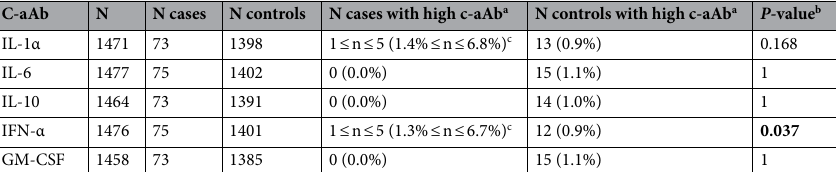
Table 4. Number and proportion of RLS cases and controls with high c-aAb (IL-1α, IL-6, IL-10, IFN-α and GM-CSF -specific autoantibodies). a High c-aAb is classified as having a c-aAb level above the 99th percentile of the given c-aAb dataset. b Statistical significant difference tested through Fisher’s exact test. c The number